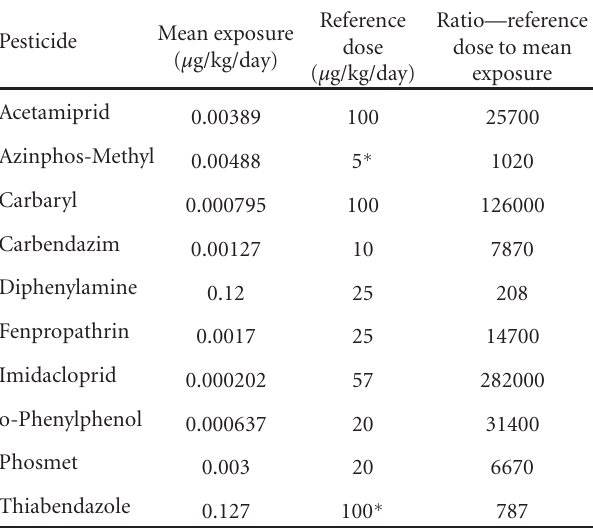
Table 2: Exposure estimates of the ten most frequently detected pesticides on apples.